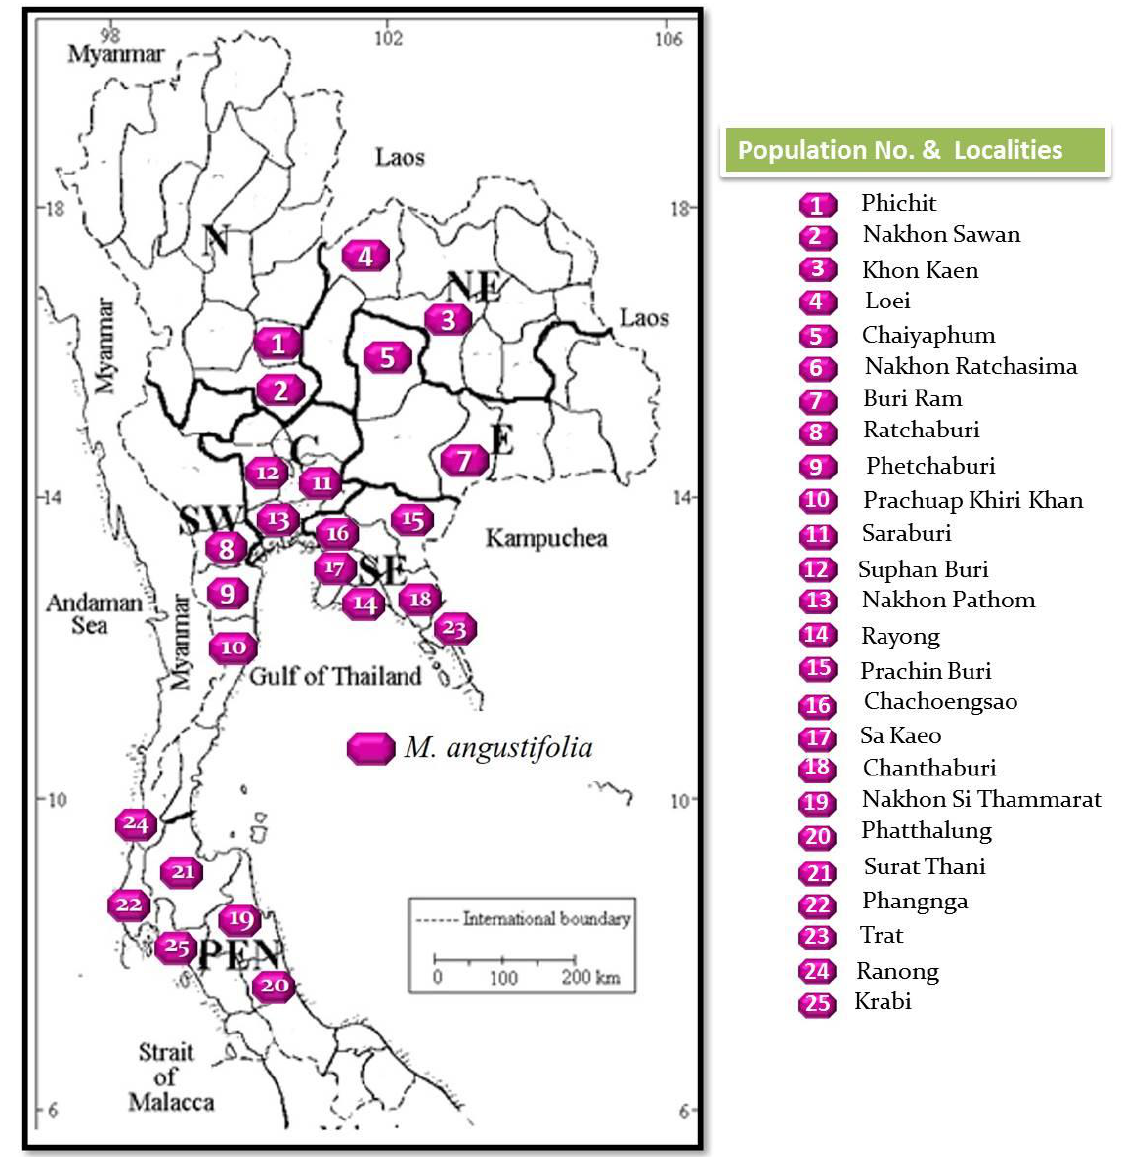
Figure 2. Distribution map of M. angustifolia populations throughout the floristic regions in Thailand. Numbers 1 – 25 indicate the number of populations.